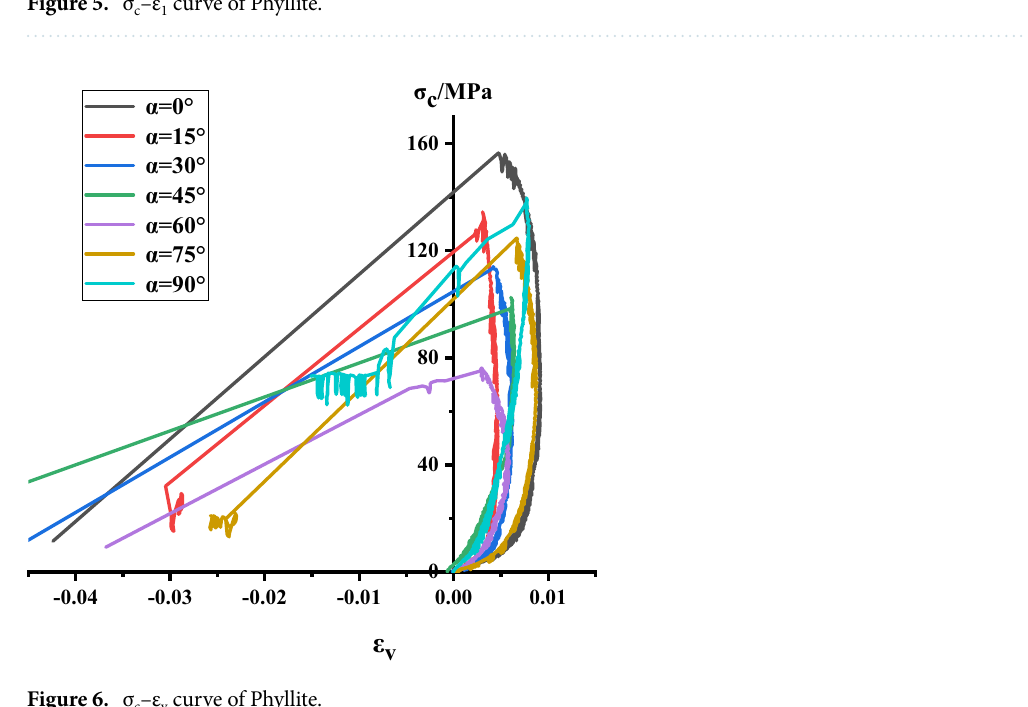
Figure 6. σ c –ε v curve of